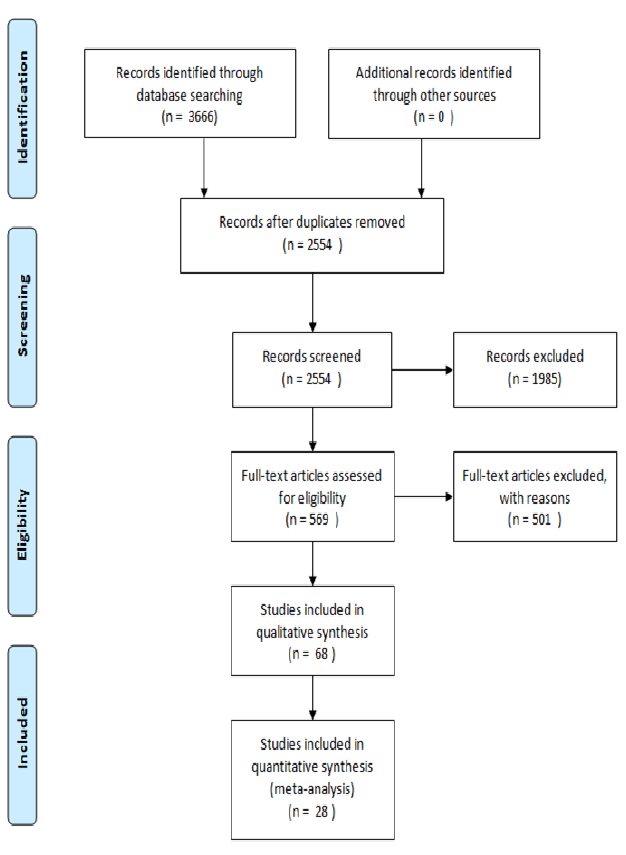
Figure 1. Prisma flow diagram of review article selection.